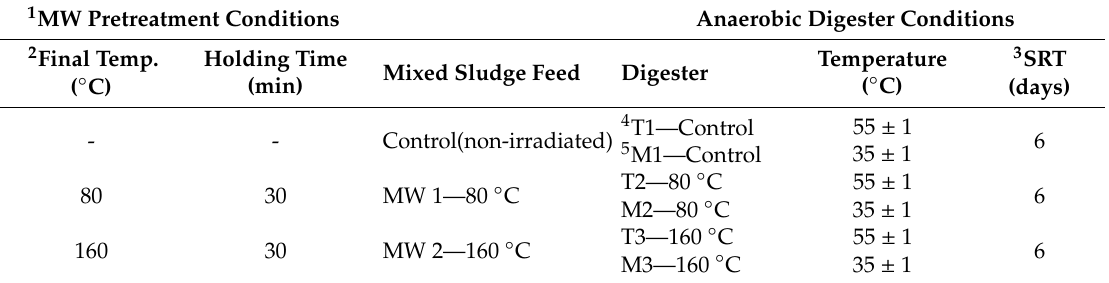
Table 2. The experimental design used for MW pretreatment and anaerobic digesters.